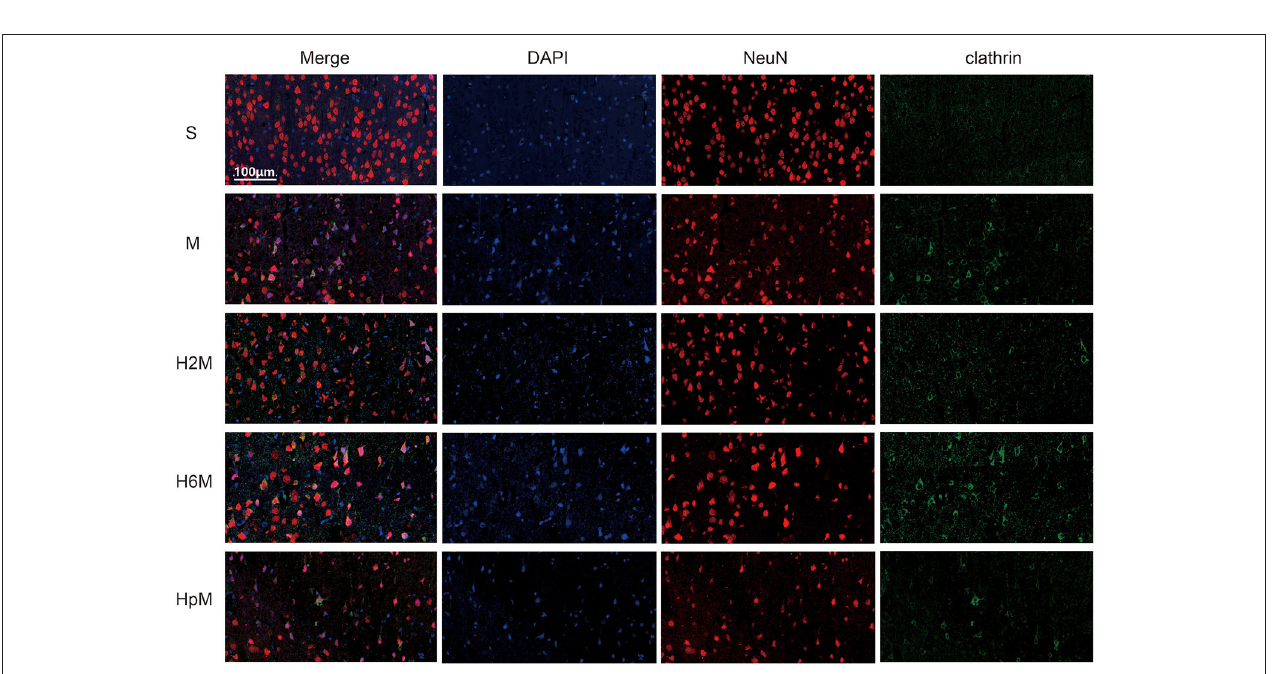
FIGURE 8 | Clathrin and NeuN immunofluorescence double labeling. Neurons in the periinfarct region were co-stained with clathrin-positive cells after the MCAO procedure. The remaining neurons in each group showed positive staining of clathrin in different degrees. Neurons in the periinfarct region of rats after MCAO surgery showed partial clathrin-positive staining, while no clathrin-positive cells were observed in other cell types. NeuN, neuron-specific nuclear protein.